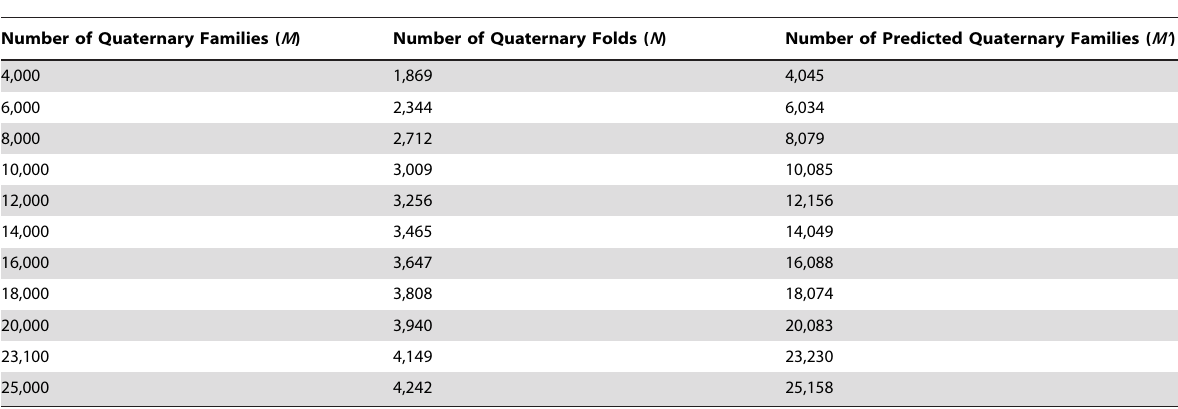
Table 1. Number of estimated complex folds for a range of numbers of complex families.